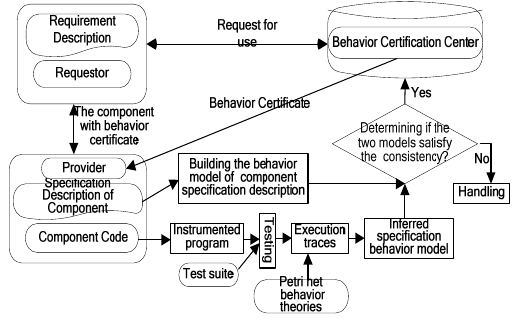
Fig. 2. The methods of component specification consistency and behavior